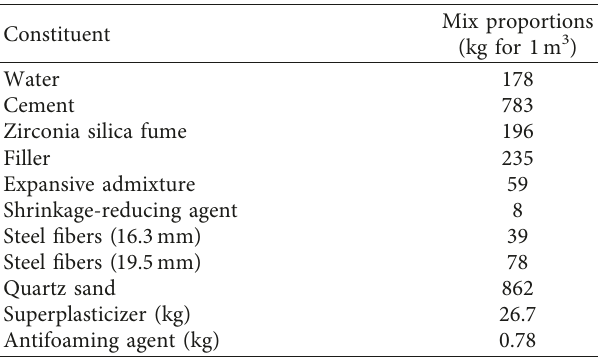
Figure 1: Configuration of each specimen (reproduced from Jang et al. [29]): (a) monolithic case (MN-0); (b) joint with the smooth contact surface (VC-0); (c) joint with 20mm size grooves (GR-20); (d) joint with 30mm size grooves (GR-30). Table 2: UHPC mix proportions.